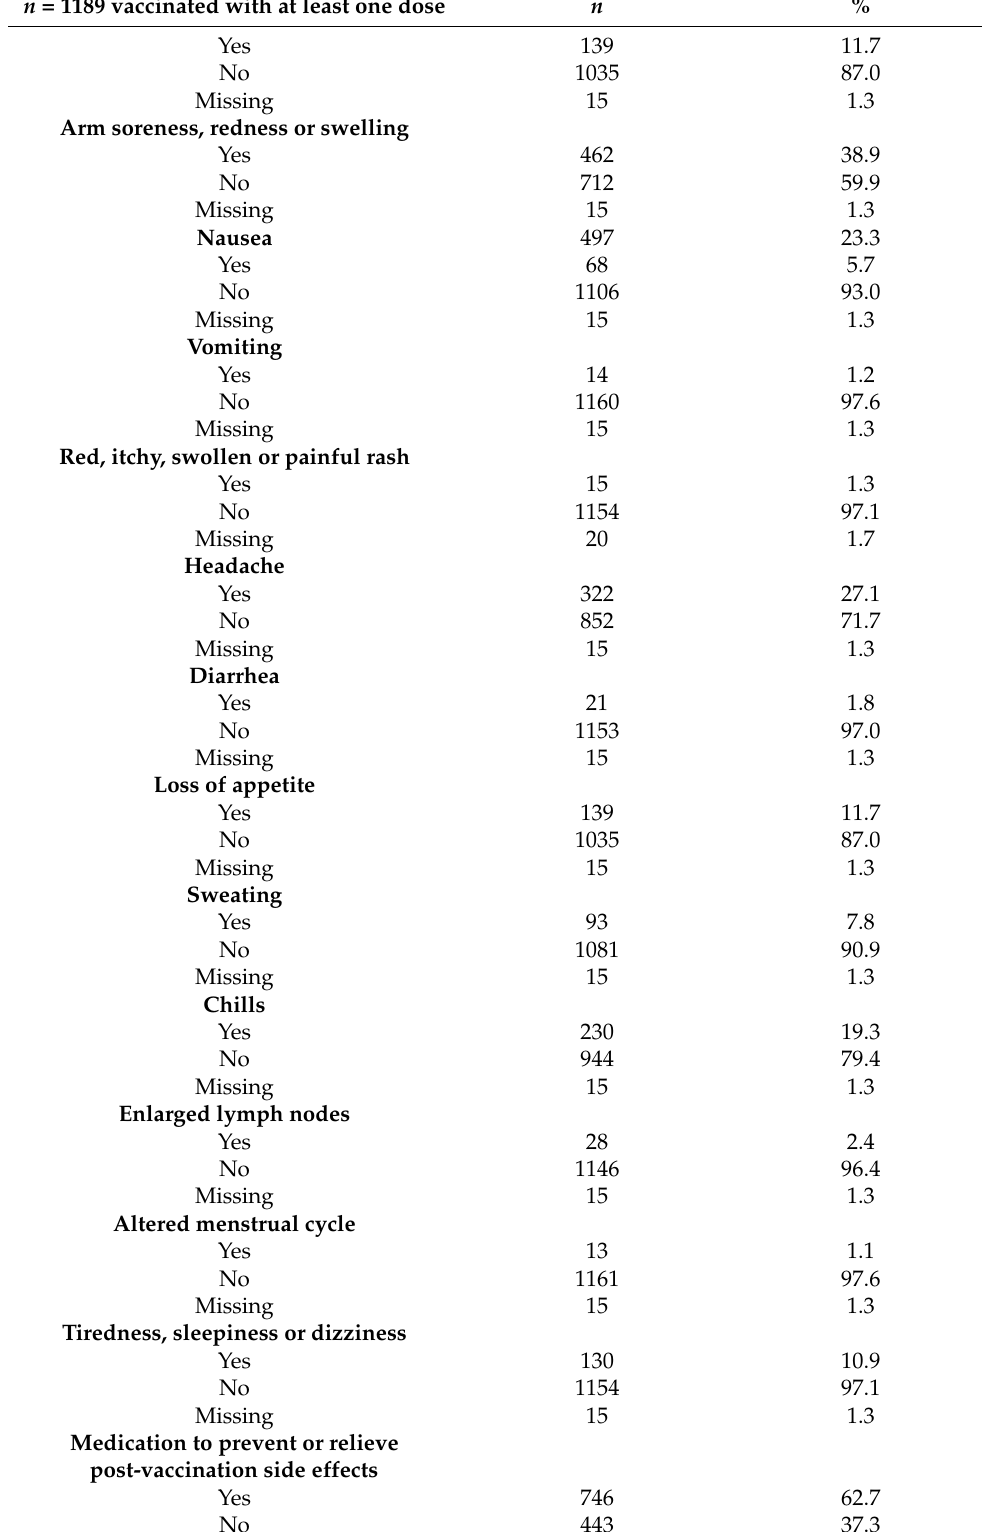
Table 2. Cont. n = 1189 vaccinated with at least one